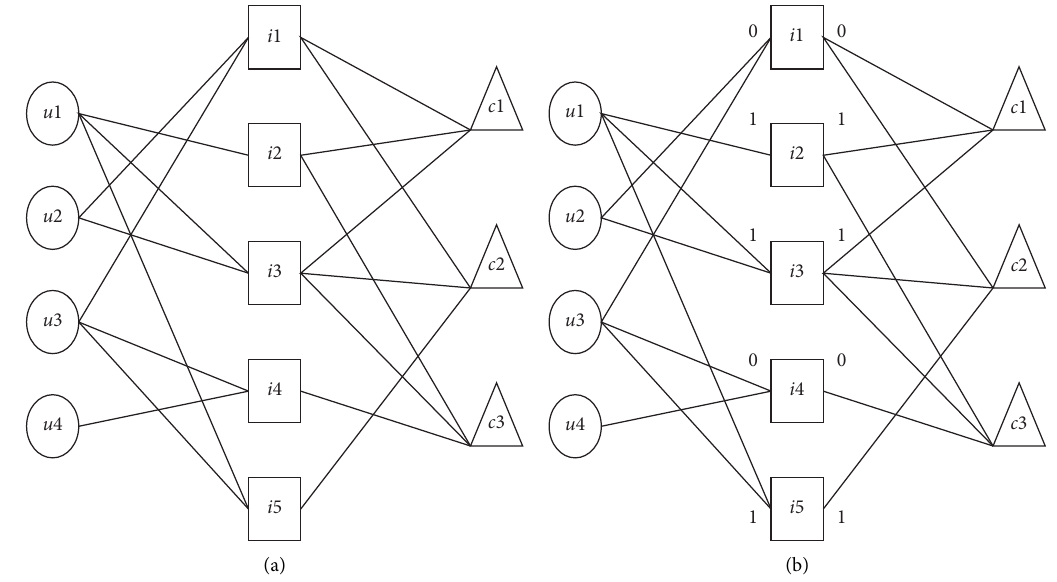
Figure 4: Processing of the tripartite graph based on heat